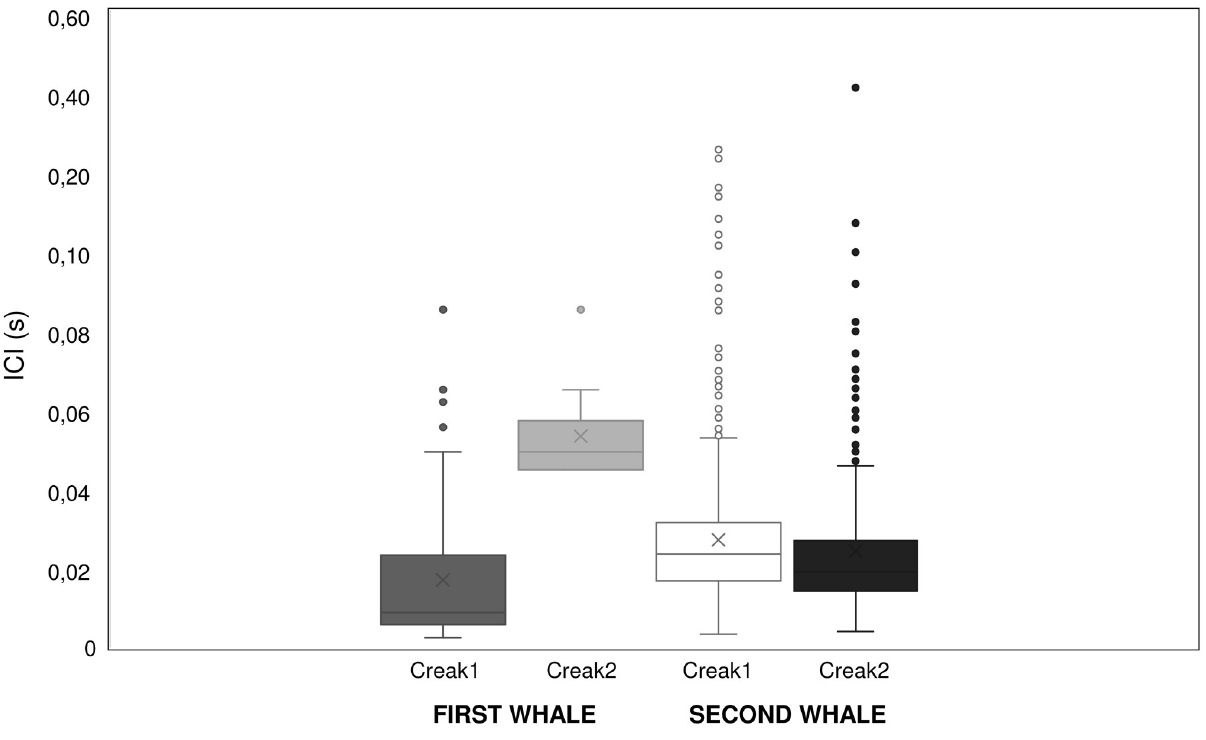
Fig 8. ICI (s) for each creak series in both